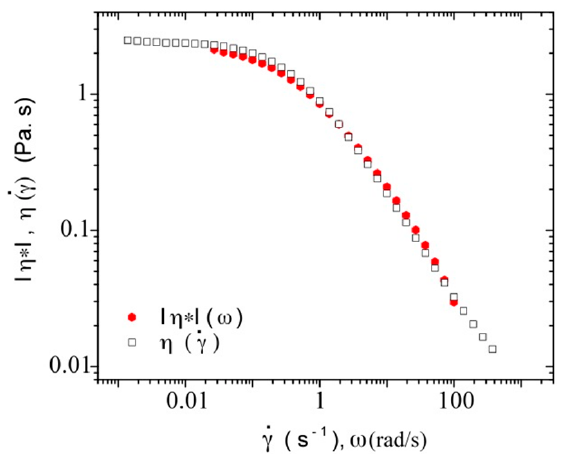
. Figure 17. | η * | ( ω ) and η ( (cid:2011) (cid:4662) ) as a function of shear rate and radial frequency for a DNA concentration Figure 17. | η * | ( ω ) and η ( γ ) as a function of shear rate and radial frequency for a DNA concentration